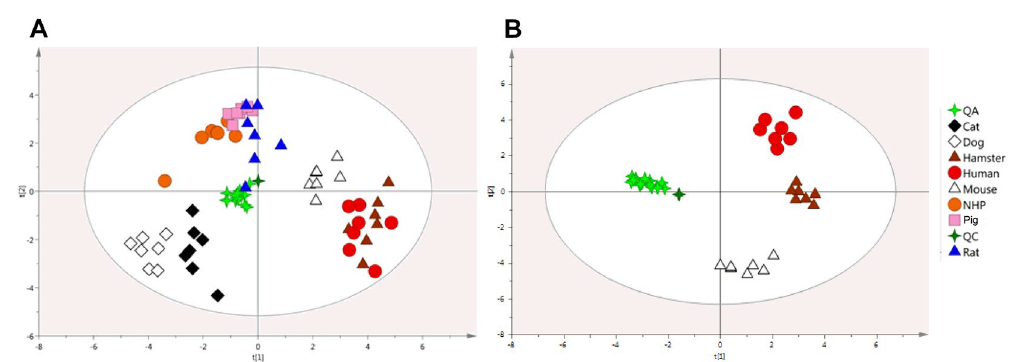
Figure 4. Comparison of targeted plasma lipid fingerprints of humans, mice and hamsters. ( A ) Principal component analysis (PCA) model based on 106 identified lipids from the lipid fingerprints of human and non-herbivorous animal species plasma samples (n = 8 × 6), R2X = 0.753; Q2 = 0.498. PC contributions: PC1 = 0.223, PC2 = 0.136. (B) PCA model based on 106 identified lipids from the lipid fingerprints of human, mouse and hamster plasma samples (n = 3 × 6), R2X = 0.776; Q2 = 0.698. PC contributions: PC1 = 0.302, PC2 = 0.169.